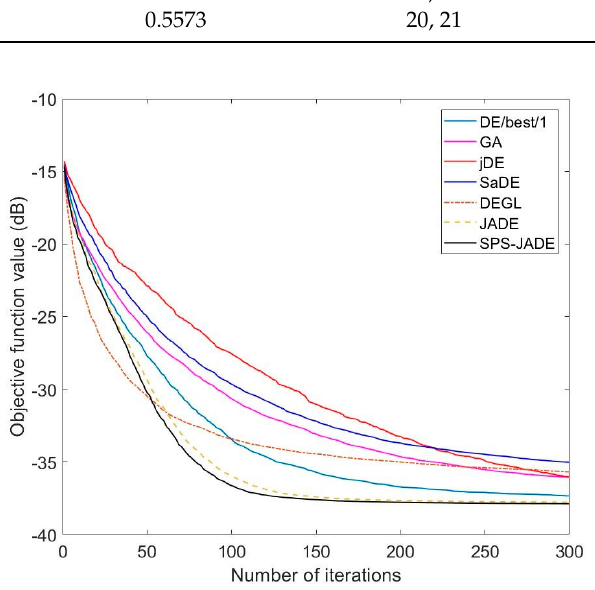
Figure 6. Average convergence rates with sidelobe suppression and null depth.